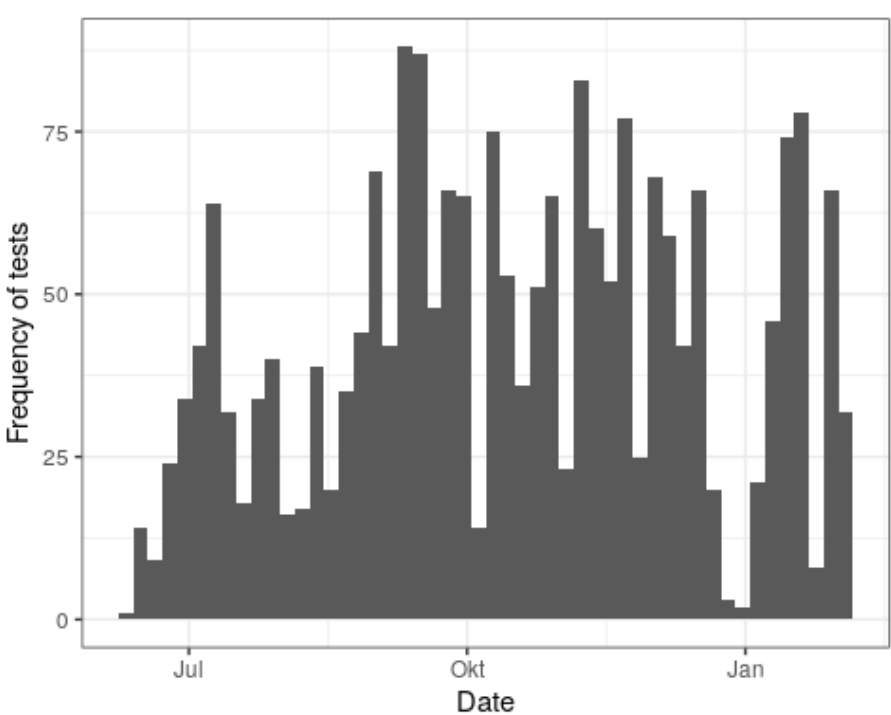
Figure 2. Test frequency by time over the study period from June 2020 to February 2021.